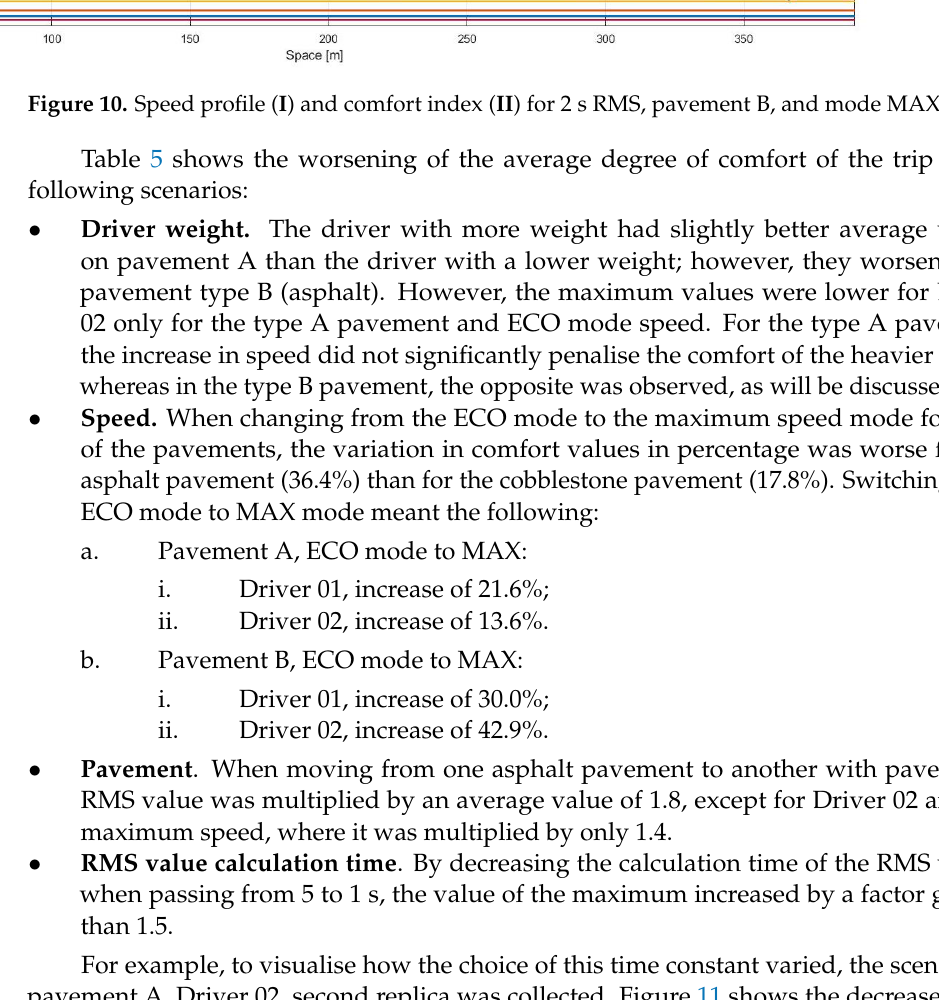
Table 5. Comfort values for RMS from 1 to 5 s.